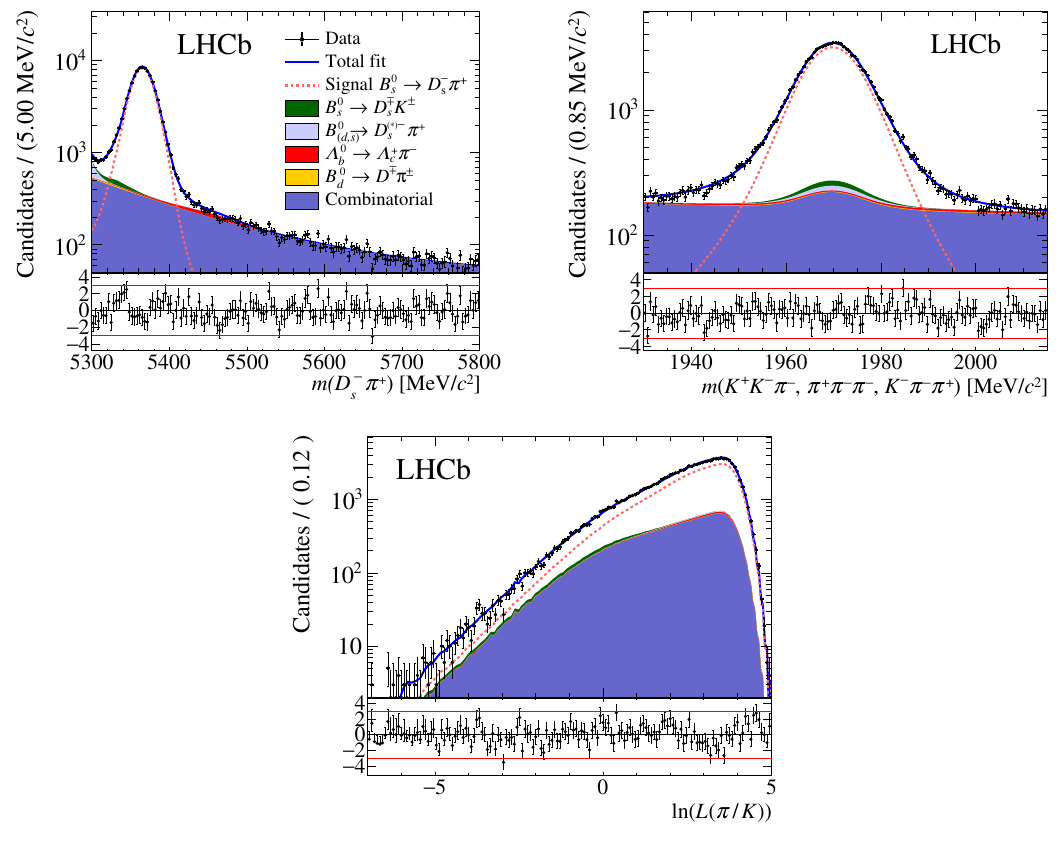
Figure 2 . Distributions of the (upper left) B 0 B 0 D (cid:0) (cid:25) + (cid:12)nal states, and (bottom) of the logarithm of the companion track PID log-likelihood, s ! s ln( L ( (cid:25)=K )). In each plot, the contributions from all D (cid:0) curve is the total result of the simultaneous (cid:12)t. The dotted red curve shows the B 0 and the fully coloured stacked histograms show the di(cid:11)erent background contributions. Normalised residuals are shown underneath all